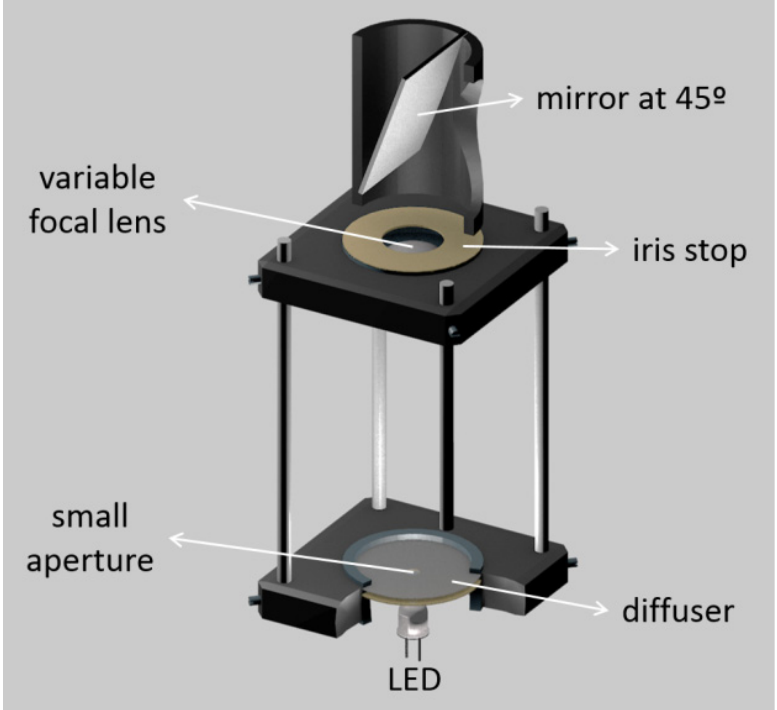
Figure 2. Three-dimensional rendering of the device used by Esteve-Taboada et al. For a description of its components, see text. Optics Express 2015, 23, 19396 ([57]). Originally published by and reprinted with permission from Optica Publishing Group.